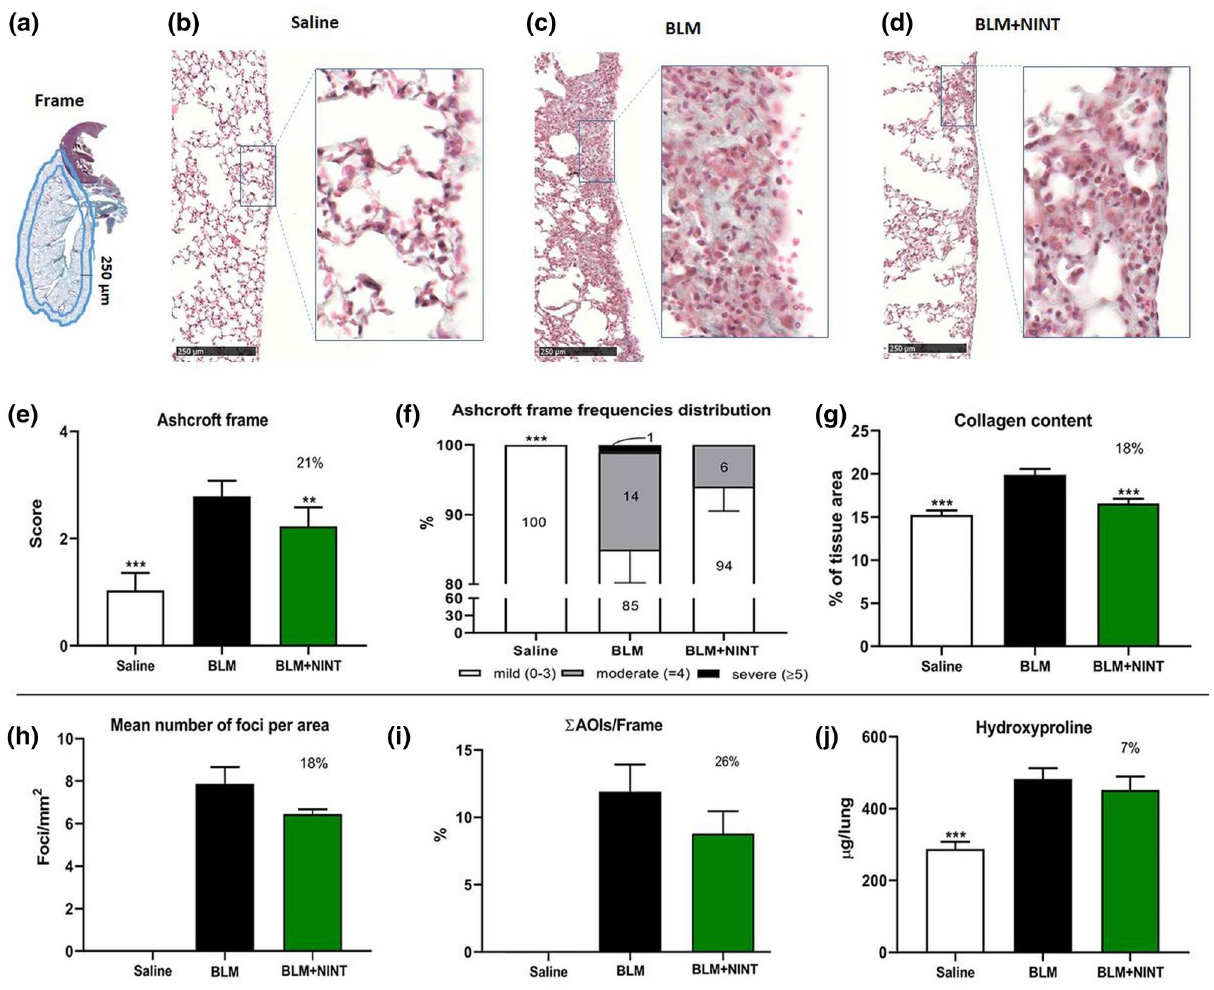
Figure 2. Histological and histomorphometric analysis of the subpleural parenchyma. Evaluation of the antifibrotic activity of nintedanib (on bleomycin induced lung fibrosis through osmotic minipumps) at day 28. ( a ) Schematic representation of the Frame 250-µm thick considered as a region of interest. ( b-d ) Representative microphotographs of the subpleural parenchyma of Saline ( b ), BLM ( c ) and BLM + NINT ( d ) treated groups at day 28 (MT staining; ×10 magnification. The area within the rectangles has been magnified at ×20). ( e ) Ashcroft score determination on the frame. ( f ) Frequency distribution (%) of the Ashcroft scores values grouped as mild (0–3), moderate (4) and severe (≥ 5). ( g ) Collagen content determination expressed as a percentage of the tissue area. h : Mean number of fibrotic foci per mm 2 of Frame. ( j ) Global AOI area (AOIs) normalized on the Frame surface (AOIs/Frame) and expressed as percentage. i: Anti-fibrotic effect of NINT on hydroxyproline concentration in the right lung. Data are shown as mean ± S.E.M. for 8 mice per group. In d, f, g, h and i, Saline and BLM + NINT were compared to the BLM group using one-way ANOVA followed by Dunnett’s test (**P < 0.01; ***P < 0.001). In e statistical comparisons with the BLM group were performed using Chi-squared test (**P < 0.01; ***P < 0.001). The percentages on the BLM + NINT bars represent the inhibition effect of the treatment compared to Immunofluorescence staining. Immunofluorescent (IF) reactions were performed on paraffin embed- ded sections to detect M2-like polarized macrophages in the lung and Collagen type I in the skin. Briefly, paraf- fin embedded sections were deparaffinized, rehydrated, and then antigen retried (in a 10 mM citrate buffer at a boiling point). After a cooling step, the slides were rinsed in a wash buffer and then immersed in a blocking buffer (0.3 M glycine, 5% bovine serum albumin in 1_ PBS; Sigma-Aldrich, St Louis, Missouri, US) at room tem- perature. Sections were incubated using primary antibody (anti-CD206: 1 µg/mL, AF2535; R&D Systems—anti- Collagen type I: 5 µg/mL, ab88147; Abcam, Cambridge, UK)). This reaction was revealed by a specific secondary antibody (donkey anti-goat antibody Alexa Fluor 488 conjugate: 3 µg/mL, AB2336933; Jackson Laboratories, Bar Harbor, Maine, US—Goat Anti-Mouse IgG, Fcγ subclass 3 specific Rhodamine Red™-X (RRX) AffiniPure (dil. 1:200; 115-295-209; Jackson ImmunoResearch, Ely, Cambridgeshire, UK). Lastly, the nuclei were coun- terstained with DAPI (Invitrogen). For negative control the primary antibody was omitted and tissues were incubated in 10 mM phosphate buffer or, alternatively, with unlabelled rabbit IgG nonimmune isotype control